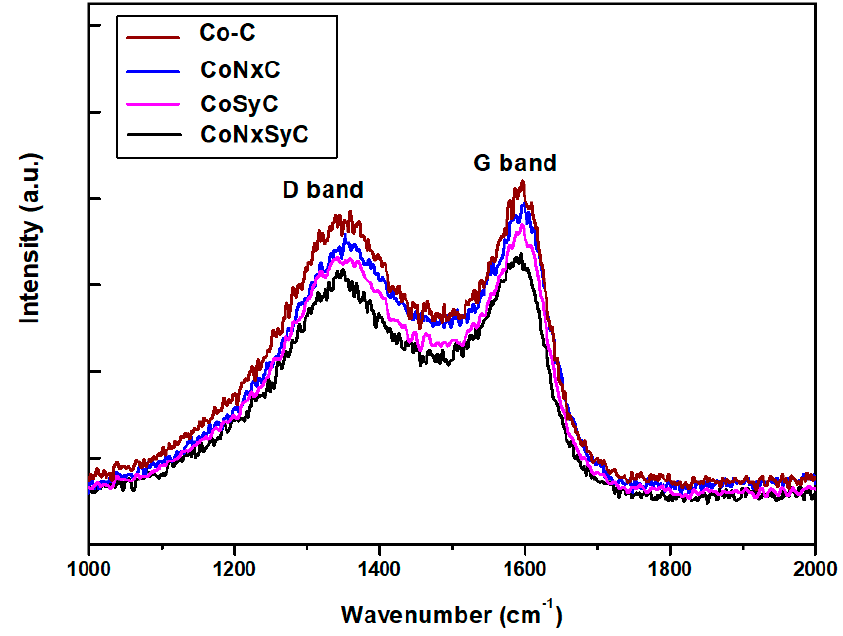
Figure 4. Raman spectra of various co-catalysts.